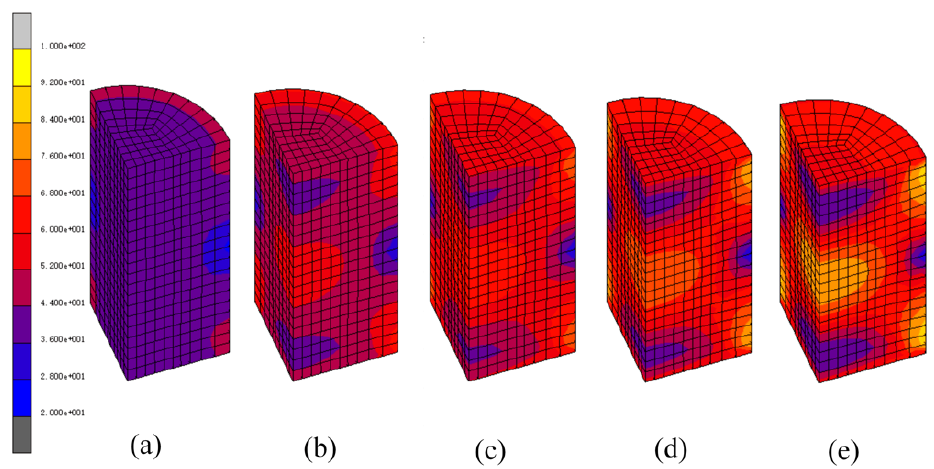
Figure 14. Equivalent von Mises stress distributions in the powder compacts with an Al content of 30 wt % at a compaction pressure, P , of ( a ) 100 MPa, ( b ) 150 MPa, ( c ) 200 MPa, ( d ) 250 MPa, and ( e ) 300 MPa.